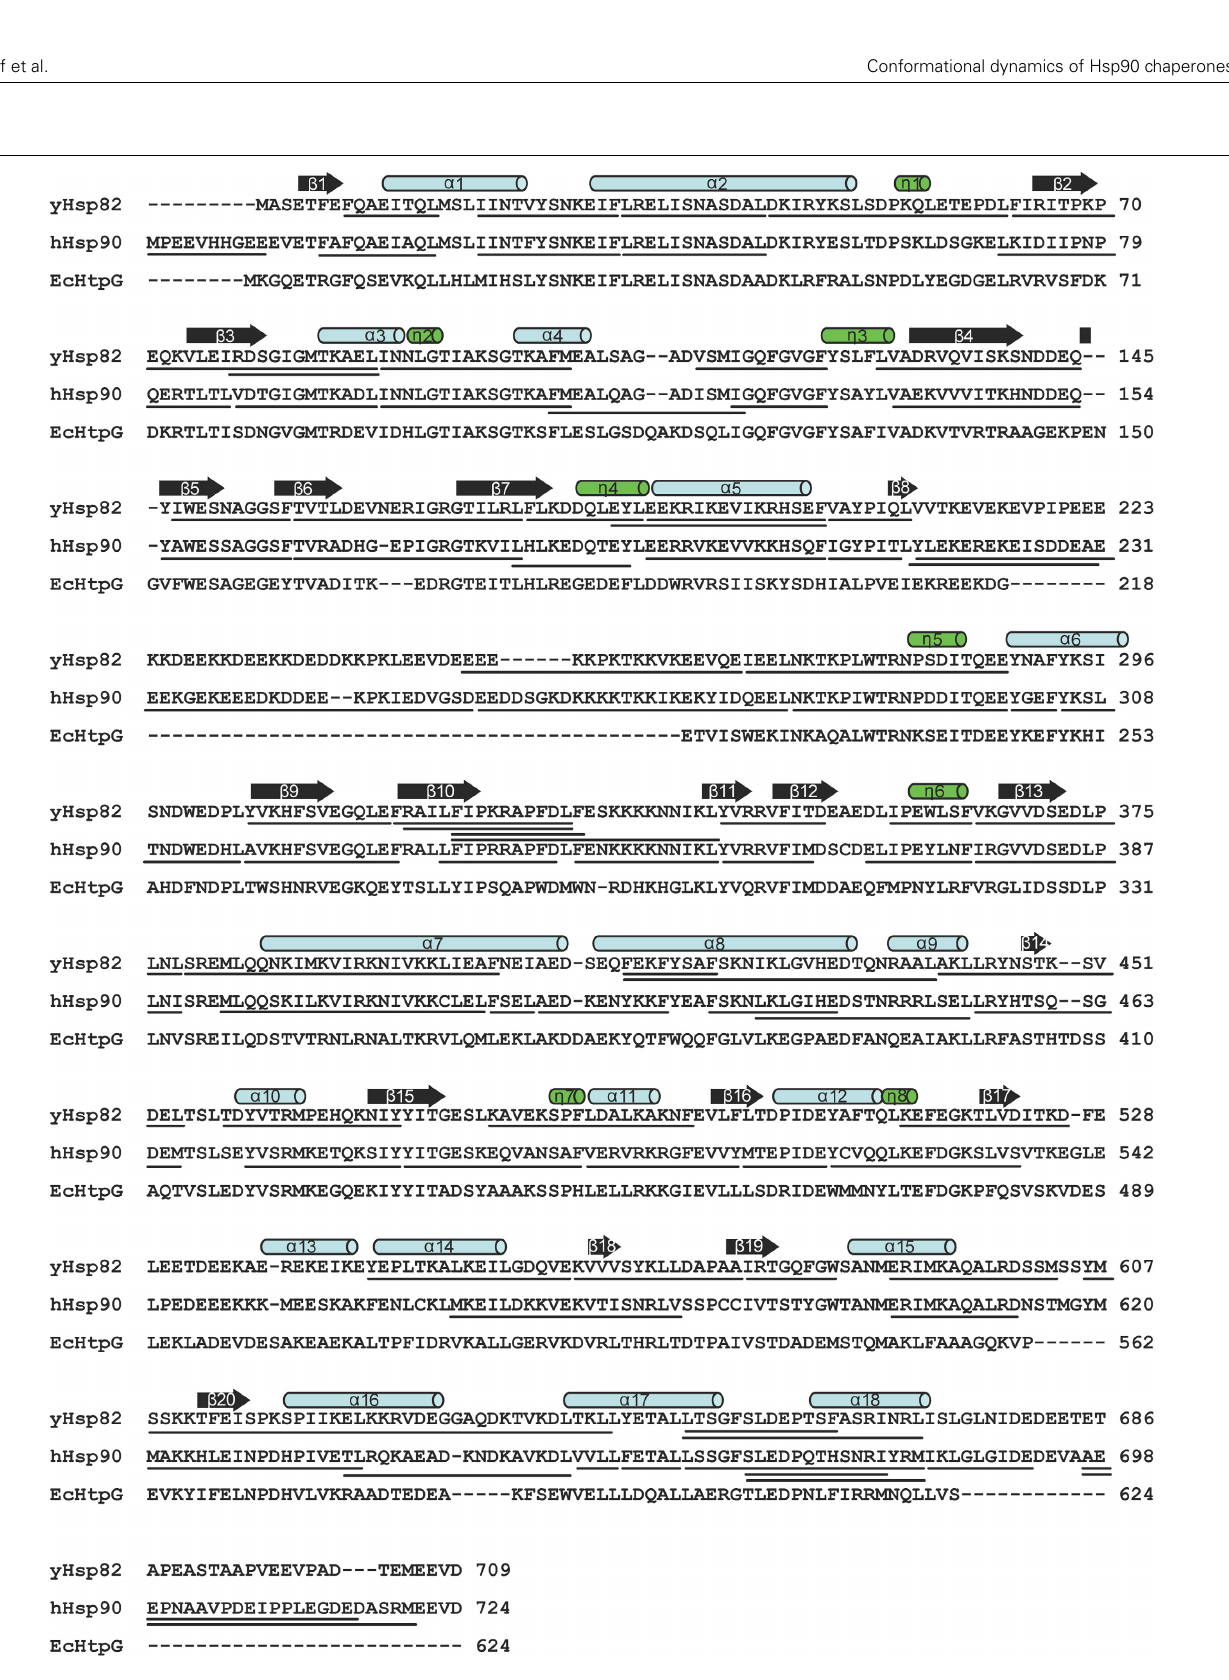
FIGURE 1 | Comparison of human, yeast and E. coli Hsp90 proteins. Clustal W sequence alignment of human, yeast and E. coli Hsp90. Secondary structure elements, α helices ( α 1–18), 3 10 helices ( η 1–8), and β strands